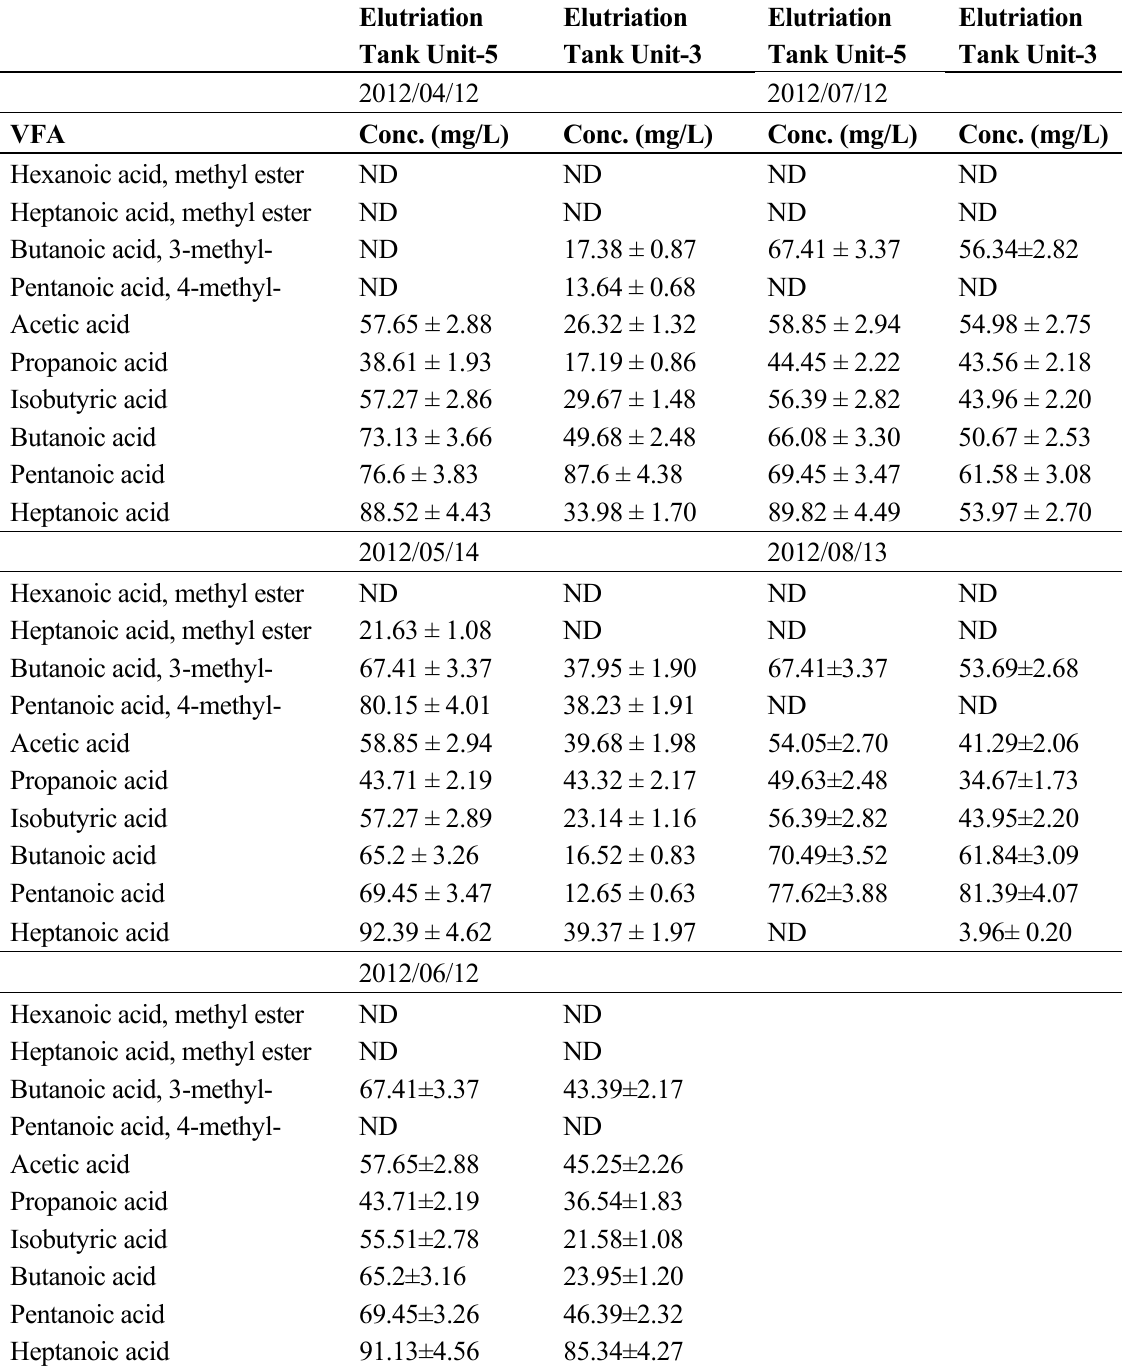
Table 3. Concentrations of volatile fatty acids in the samples collected from the elutriation tanks (Unit-3 and Unit-5), Northern Wastewater Treatment Works, Johannesburg, South